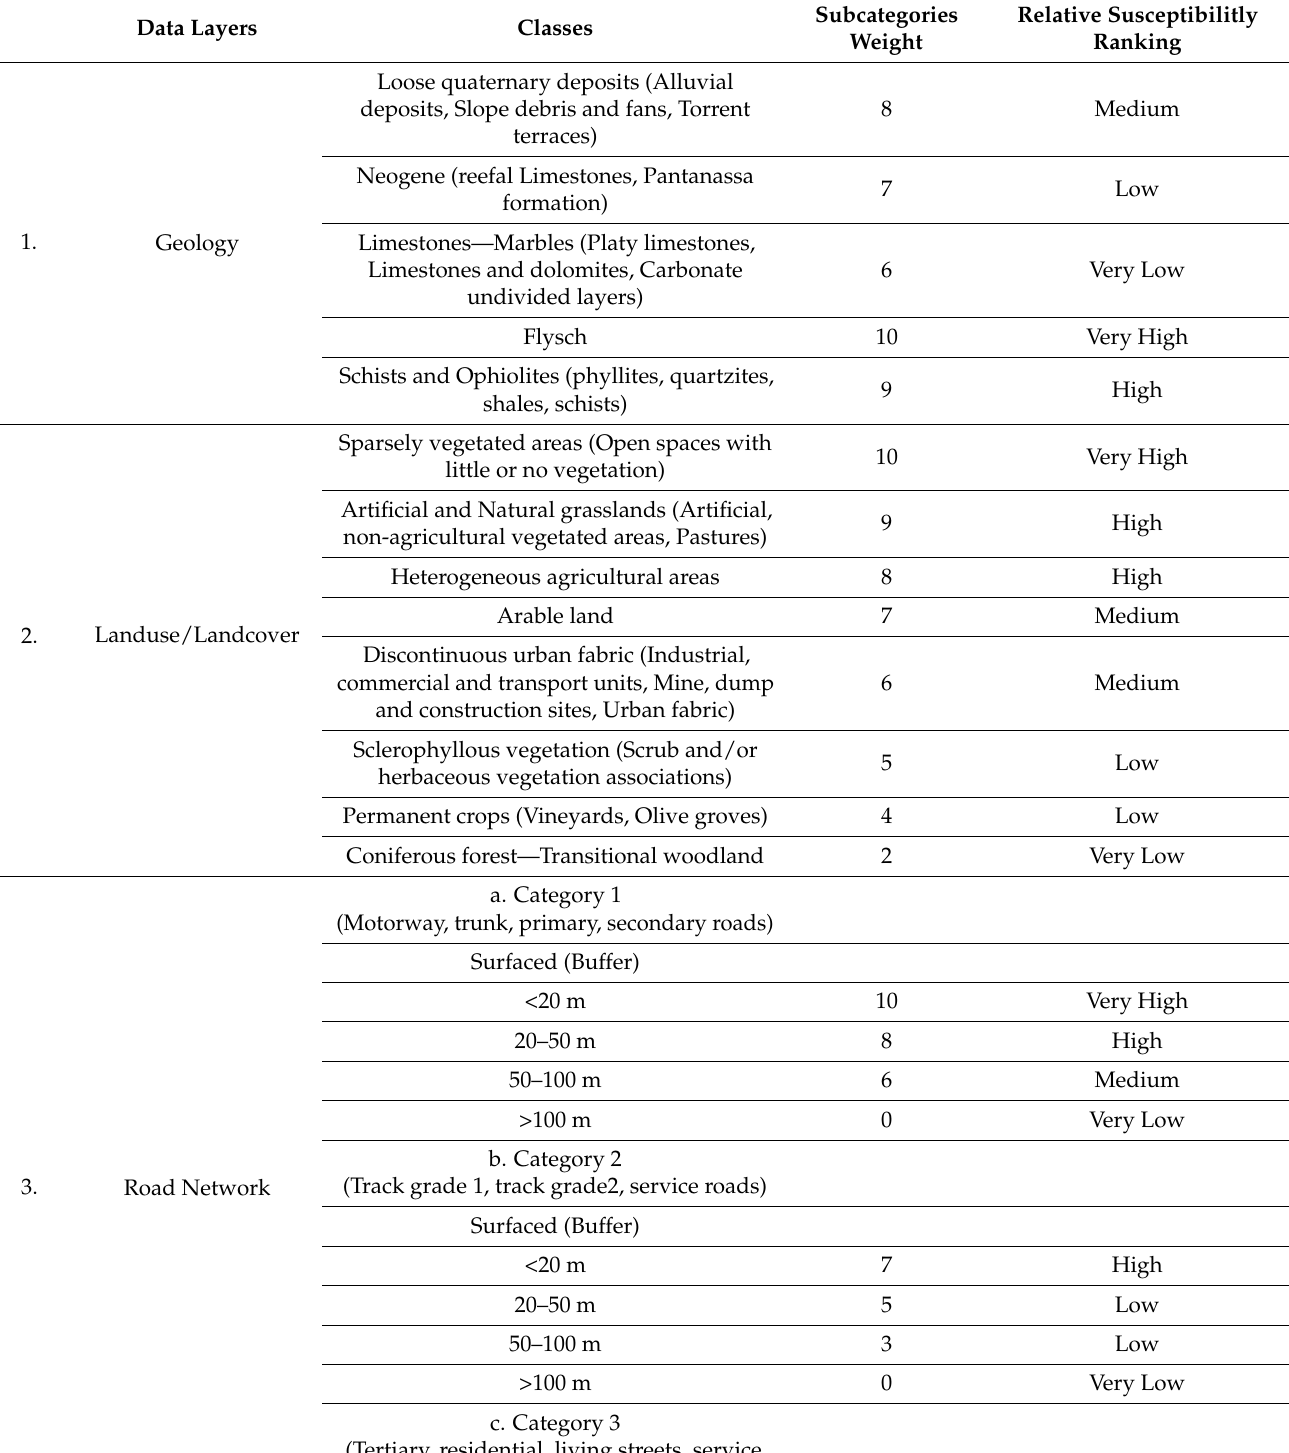
Table 4. Landslide weigh rating adopted in this study for the causal factors and their